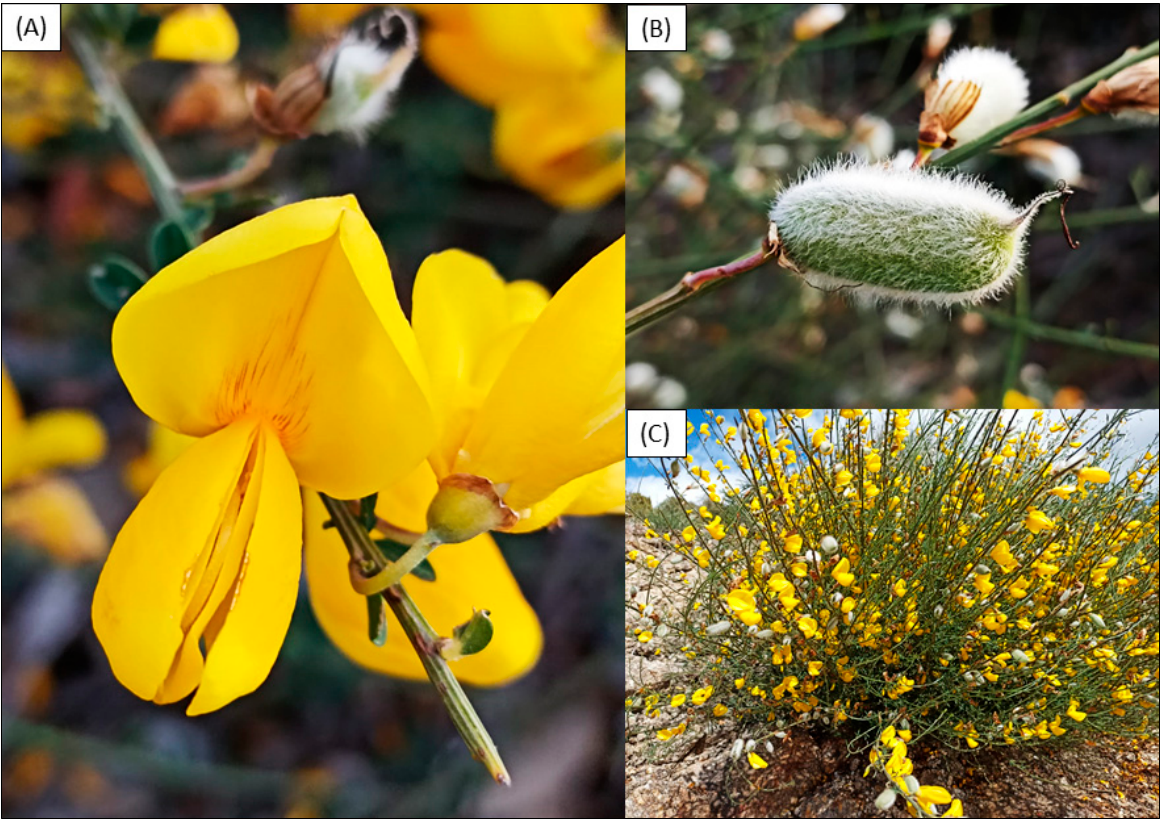
Figure 5. Some examples of C. striatus in the Beira Interior region (Portugal); ( A ) flowers of the shrub; ( B ) its characteristic fruit; ( C ) a complete shrub.